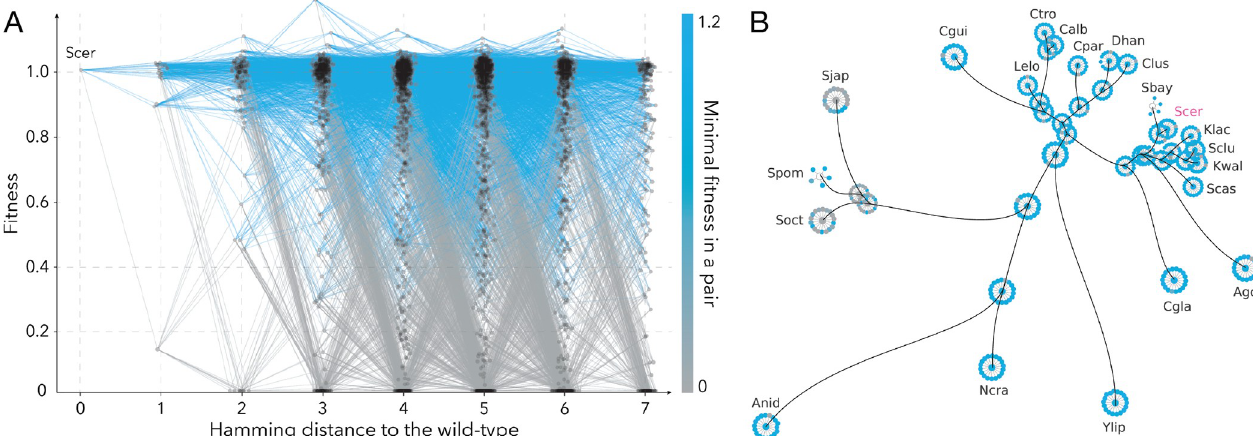
Fig 2. Visual representations of the fitness landscape. a, The fitness landscape for all assayed genotypes in segment 7. Nodes represent unique amino acid sequences with edges connecting those separated by a single amino acid replacements. Colour saturation represents the minimum fitness of the two connected nodes. b, For segment 7, fitness of ancestral and extant nodes and genotypes one amino acid replacement away from the nodes in the background of S. cerevisiae gene on the yeast phylogeny (black lines), are shown in colour ranging from grey (lowest fitness) to blue (highest fitness). The abbreviations represent the following species: Scer: Saccharomyces cerevisiae , Soct: Schizosaccharomyces octosporus , Sbay: Saccharomyces bayanus , Cgla: Candida glabrata ,